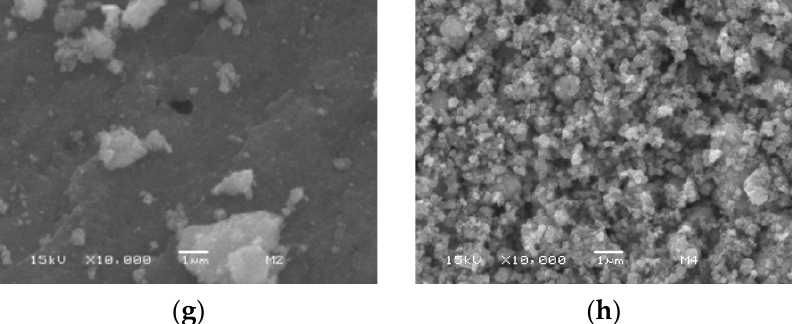
Figure 4. SEM micrographs of ( a ) NaBH 4 /Ag-TiO 2 SG 2000×, ( b ) NaBH 4 /Ag-TiO 2 MW 2000×, ( c ) NaBH 4 /Ag-TiO 2 SG 10,000×, ( d ) NaBH 4 /Ag-TiO 2 MW 10,000×, ( e ) plant extract/Ag-TiO 2 SG 2000×, ( f ) plant extract/Ag-TiO 2 MW 2000×, ( g ) plant extract/Ag-TiO 2 SG 10,000×, ( h ) plant extract/Ag-TiO 2 MW 10,000×.